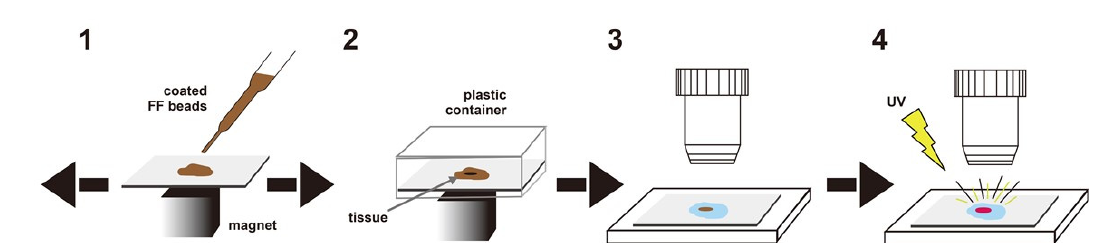
Figure 6. Scheme of magnetically promoted rapid immunofluorescence. 1: Diluted FF beads are dripped onto tumor cells, and the slide is vigorously agitated on the magnet; 2: the slide is inverted into a plastic container and washed with a magnet; 3, 4: FF beads bound to tumor cells can be observed directly by fluorescence microscopy. Modified from Onishi et al.